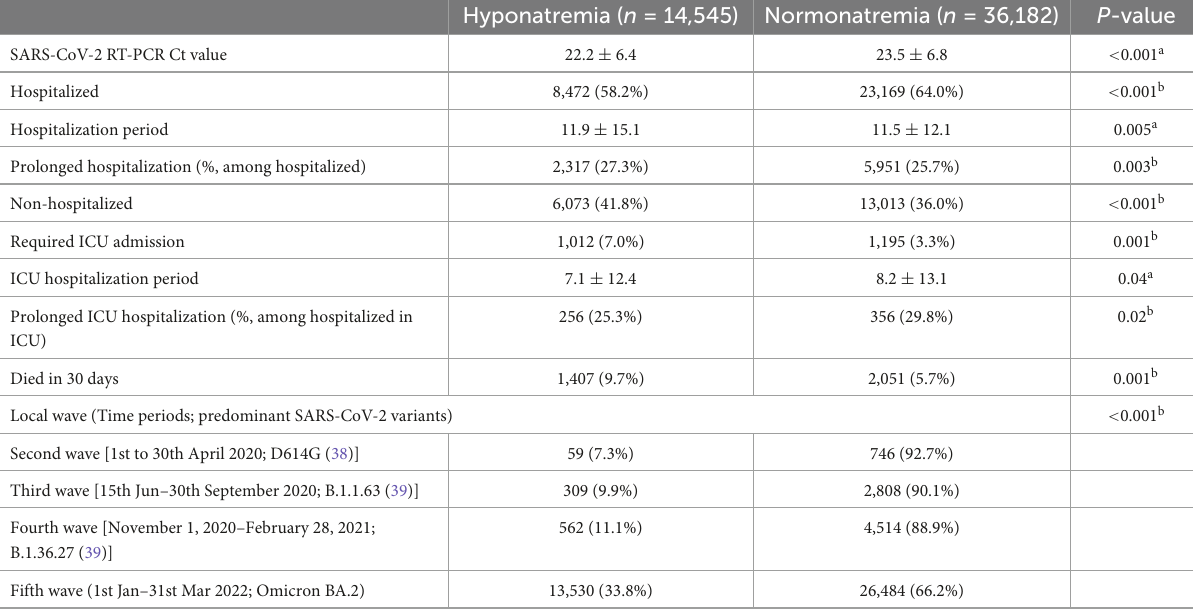
TABLE 2 The rates of hospitalization and intensive care unit admission in COVID-19 patients with or without hyponatremia at presentation and the relationships with different local waves of outbreak. Hyponatremia ( n = 14,545) Normonatremia ( n = 36,182)